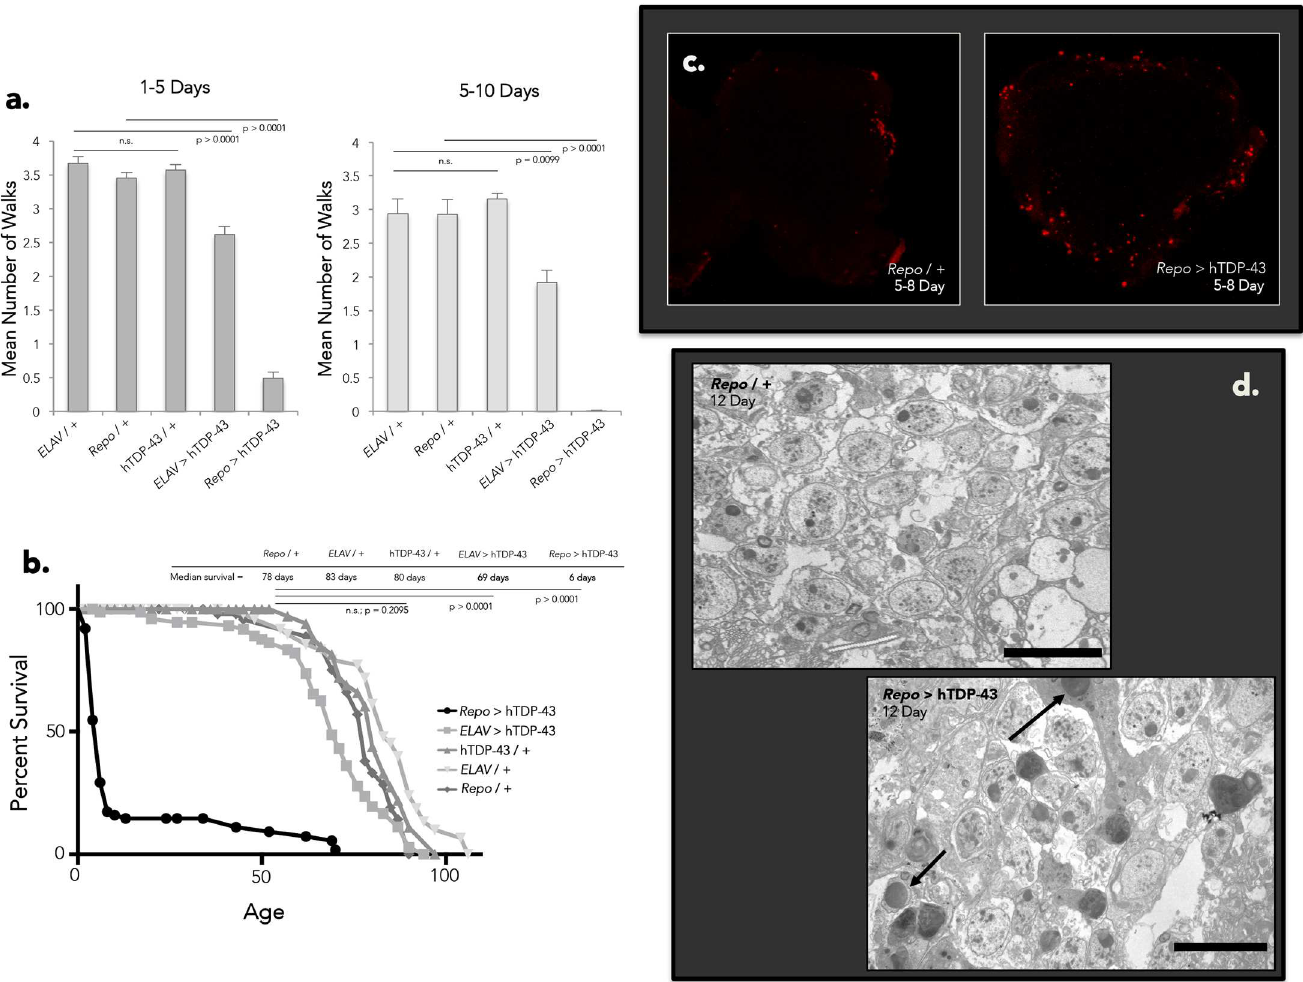
Fig 3. Neuronal and glial hTDP-43 expression induces physiological impairment and toxicity with varying severity. (A) Flies expressingglial hTDP-43 displayextreme locomotorimpairmentat 1–5 days post-eclosion in the Benzer fast phototaxisassay, whileflies expressingneuronalhTDP-43 demonstrate a slight locomotordeficit in comparison to genetic controls (one-way ANOVA, p < 0.0001). This trend continuesand is exacerbated by 5–10 days post-eclosion (one-way ANOVA, p < 0.0001). Four biological replicates performed for each experiment. (B) Lifespananalysisof flies expressing neuronal versus glial hTDP-43 in comparisonto geneticcontrols. (C) Central projections of whole-mount brains reveals a stark increasein TUNEL- positive cells in flies expressingglial hTDP-43 in comparisonto geneticcontrols at 5 days post-eclosion. N = 16 for Repo / + and N = 18 for Repo > hTDP- 43. (D) TEM likewise reveals rampant apoptosisin the neuropilof flies expressingglial hTDP-43 at 12 days post-eclosion. Arrowheads indicate pro- apoptotic nuclei,as identifiedby